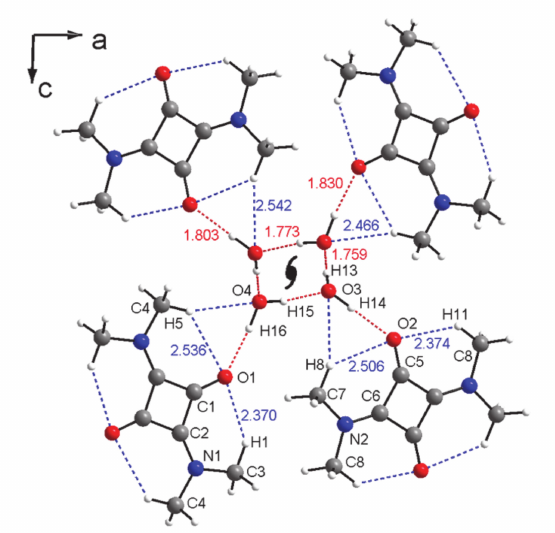
Figure 4. View of the main hydrogen bond (HB) motifs along the monoclinic b axis of SQDH at T = 20(1) K. Co-crystallized water molecules fold around the 2 1 axis, forming strong OH ··· O HBs (dashed red lines) with keto groups in squaraine. Both intramolecular and intermolecular weaker CH ··· O bonds (dashed blue lines) are also set up. Independent HB distances are